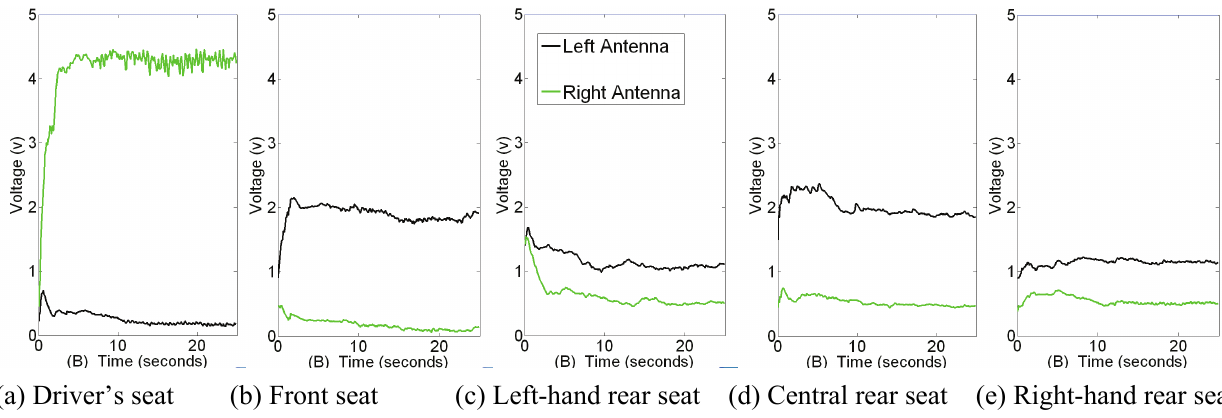
Figure 7. Energy captured by the rectenna